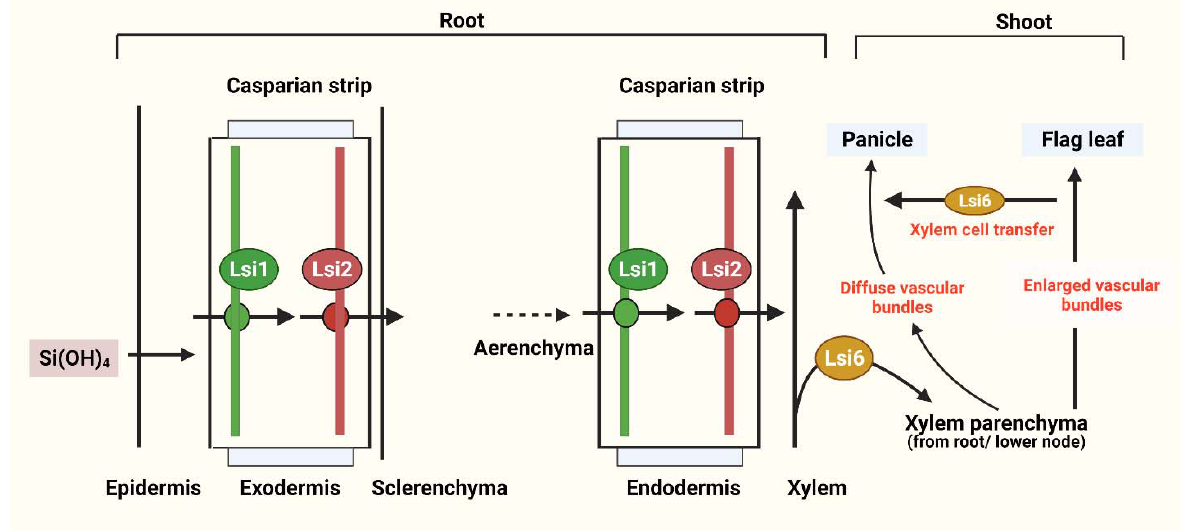
Figure 2. Diagram illustrating Si uptake by roots and its flow through a rice plant (root and shoot), using Si transporters. Lsi1 is localized in the plasma membrane and is responsible for uptake, whereas Lsi2 transports Si into the apoplast across the parenchyma and Lsi6 transports Si from the leaf to the panicles. Modified with reference [18]. Created with BioRender.com.